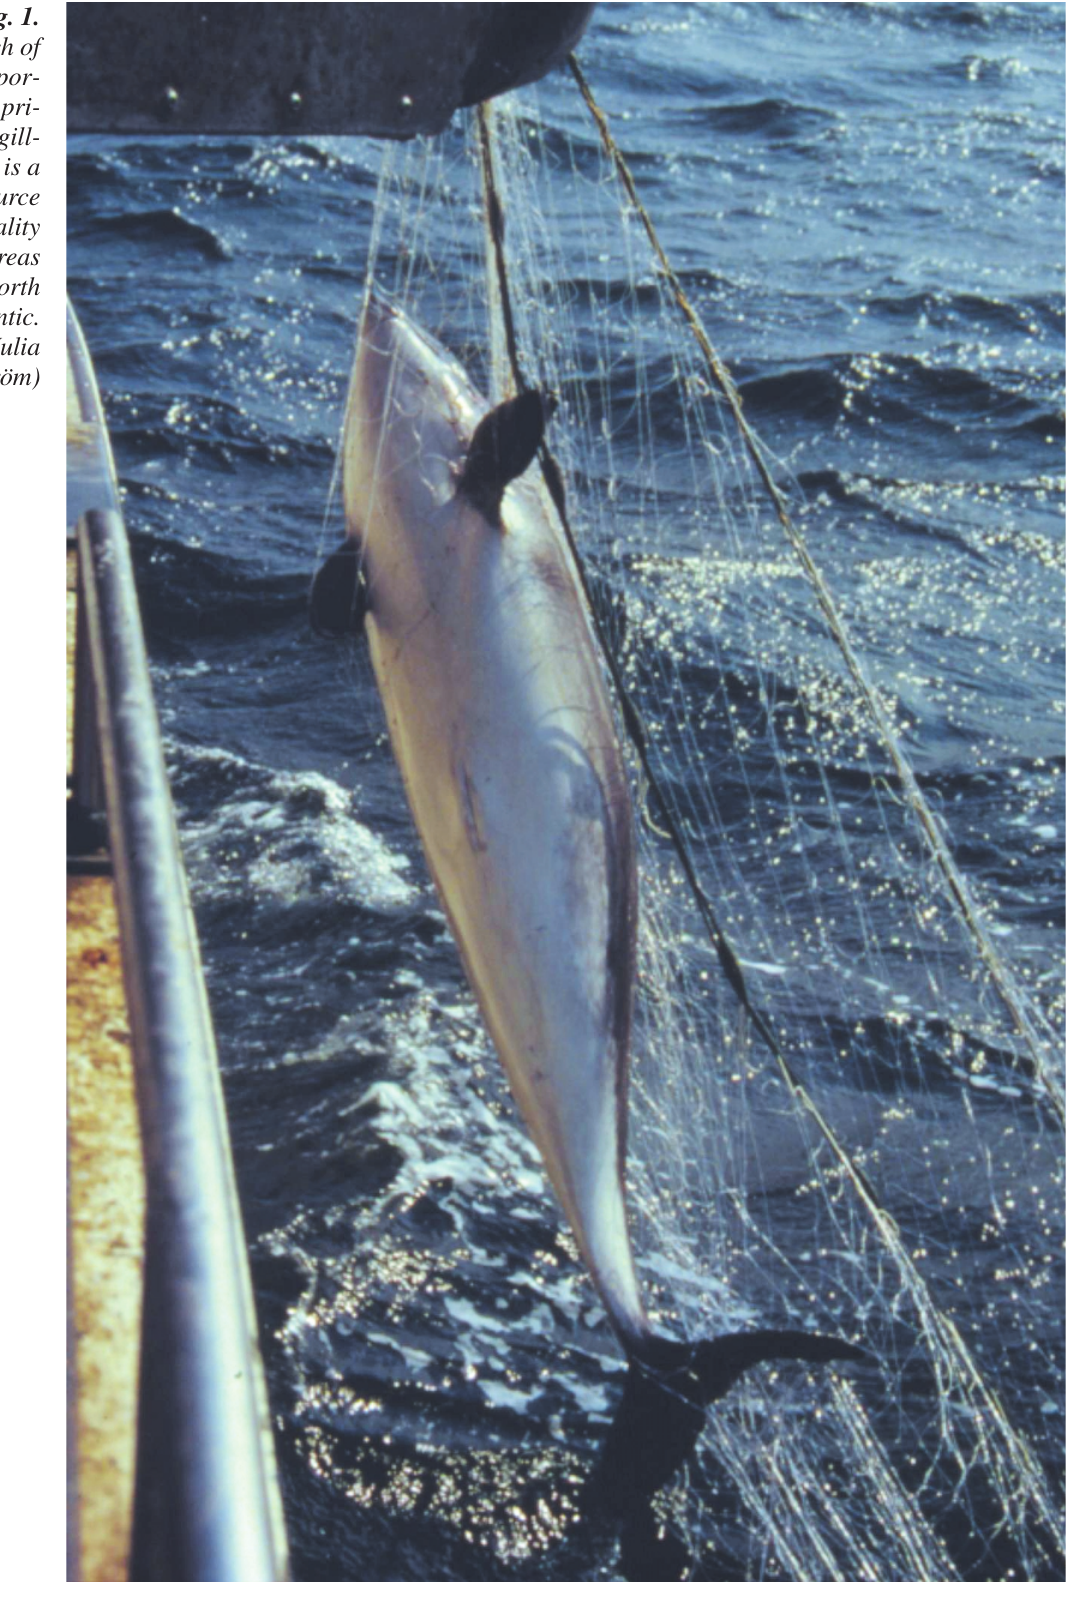
Fig. 1. Bycatch of harbour por- poises, pri- marily in gill- nets, is a major source of mortality in some areas of the North